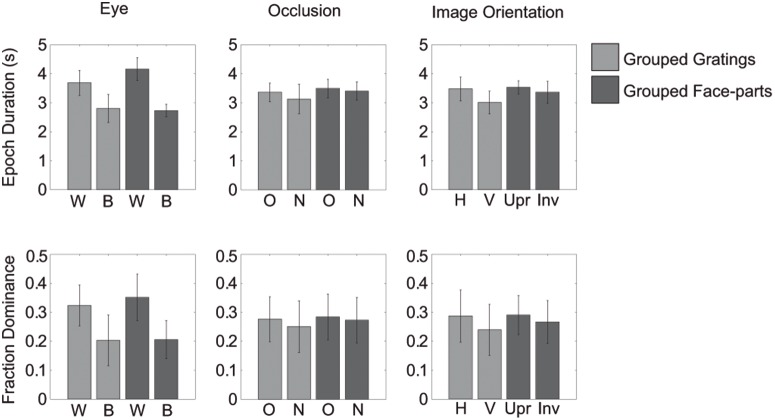
Main effects of Experiment 2.Overview of main effects for within- versus between eye dominance, occluded versus not occluded and image orientation for grouped gratings (light grey) and grouped face-parts (dark grey). Error bars represent 95% confidence intervals. The top three panels depict the average median epoch duration for grouped gratings (light grey) and grouped face-parts (dark grey). Each participant’s data was normalized using his or her overall median dominance duration. After averaging across participants the averages were multiplied by the overall median across all participants, which resulted in a duration in seconds. Note that the data normalization was for graphical purposes only since we used a within-subjects statistical design. The bottom three panels depict the fractions of overall dominance for grouped gratings and grouped face-parts. The different conditions are denoted on the abscissa as follows: W: within-eye, B: between-eyes, O: occluded, N: not occluded, H: horizontal, V: vertical, Upr: upright, Inv: Inverted. Note that between-eye grouping (left panels, conditions B) reflects grouping based on image-content only.